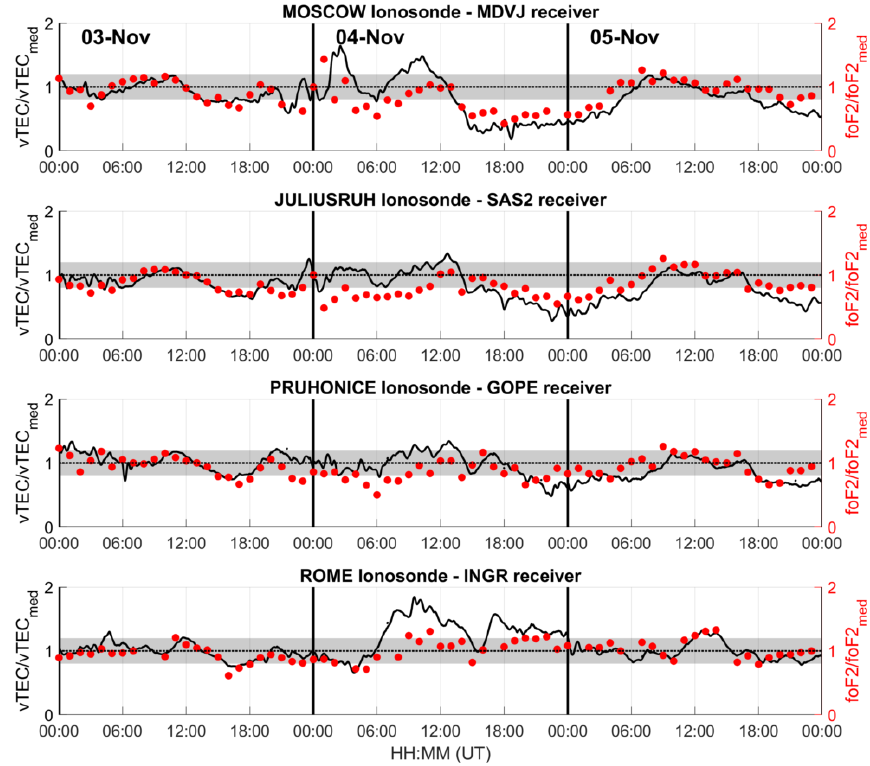
Figure 6. Time profiles of the ratio between vTEC, during 3–5 November 2021, and the median values evaluated in the 27 days preceding 3 November 2021 (black curve) and of the same quantity evaluated for foF2 (red dots). Black shaded area indicates the [0.8; 1.2] variability range during quiet times.